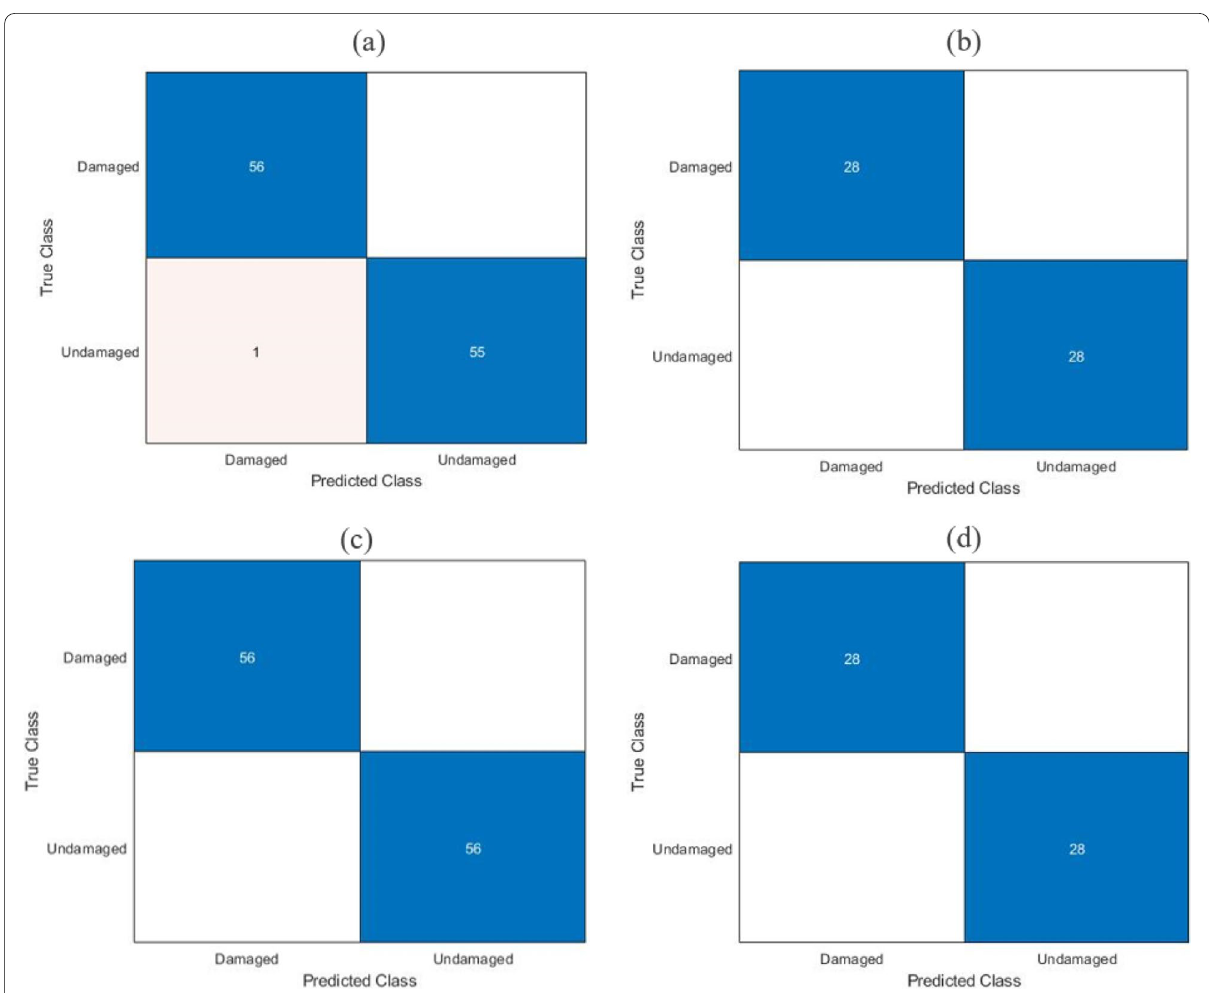
Fig. 13 Confusion matrices ( a-b ) for validation and testing using damaged and undamaged data from A 1 and ( c-d ) for validation and testing using damaged and undamaged data from